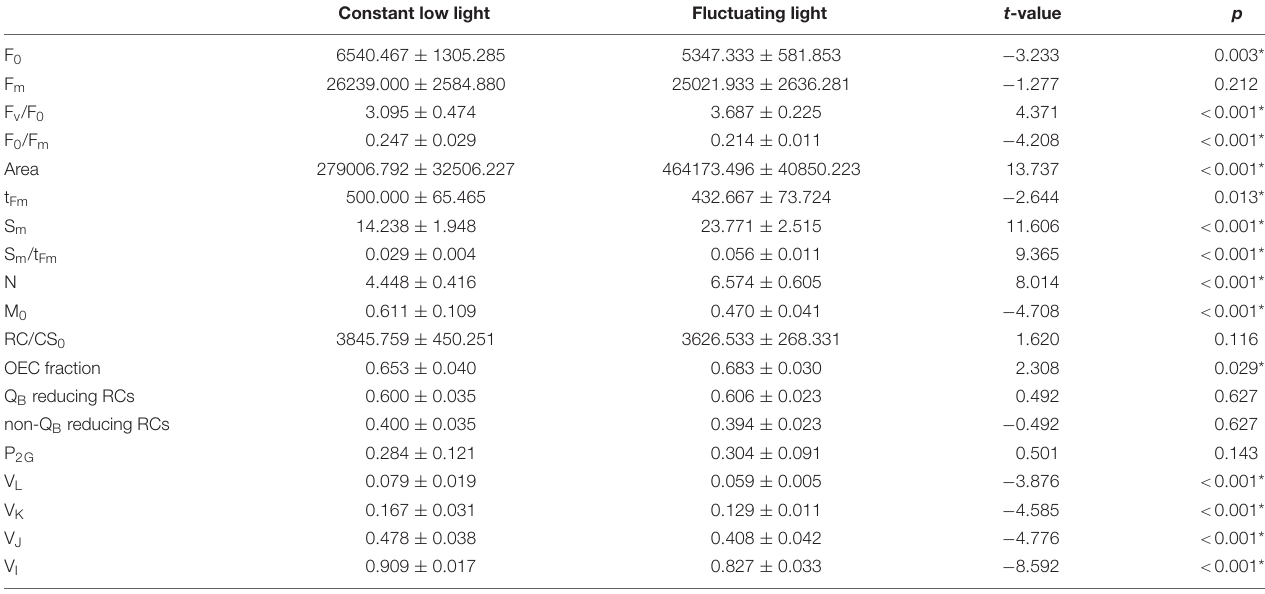
TABLE 2 | Selected parameters of the chlorophyll a fluorescence, characterizing PSII functioning gained from measurements of the Japanese knotweed ( Reynoutria japonica Houtt.) leaves exposed to constant low and fluctuating light. Constant low light